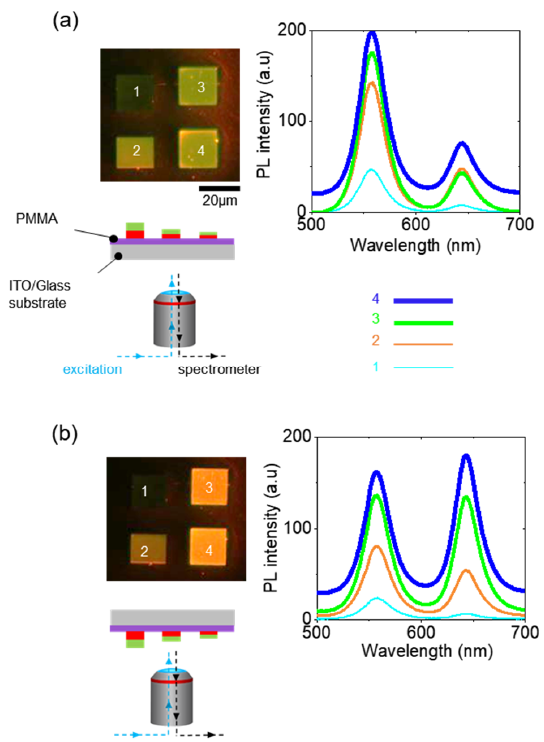
Figure 5. PL mapping and corresponding spectra of four co-assembled squares (initially charged with voltage pulses ranging from +40 V to +80 V, from 1 to 4), composed of a first red NP level with a second green NP level on top, where measurements were made from ( a ) the substrate side and ( b ) the assembly side. The scale bar is identical for both sets of PL images.